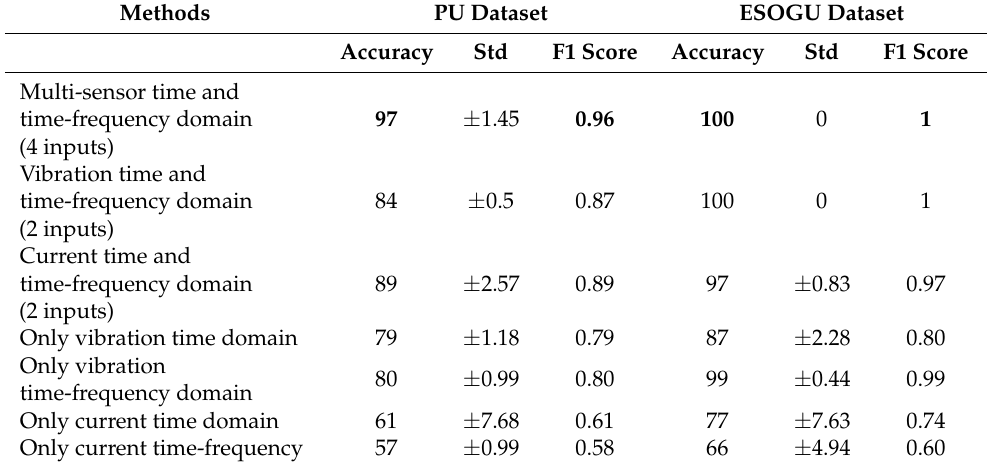
Table 1. Comparison of DL models for various types of sensor data and different datasets. Accuracy (%) values are the mean ± std over five trials.